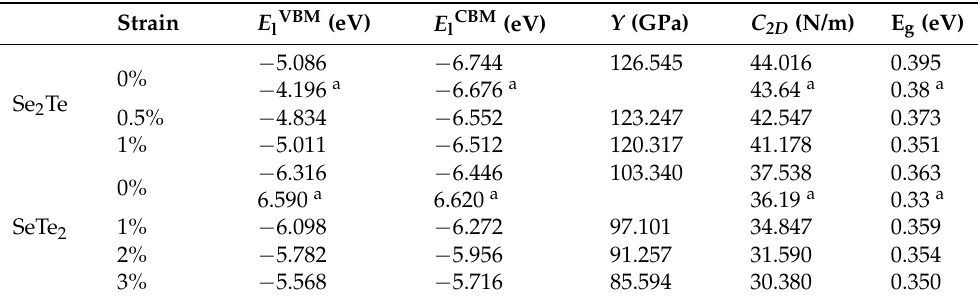
Figure 3. (Color online) Band structures and TDOS of ( a ) Se 2 Te and ( b ) SeTe 2 under various biaxial tensile strains. Table 1. Deformation potential constants ( E l ) of α -phase SeTe 2 and Se 2 Te based on PBE + SOC band structures under various tensile strains, together with the Young’s modulus Y, elastic modulus C 2D , and bandgap E g , respectively.